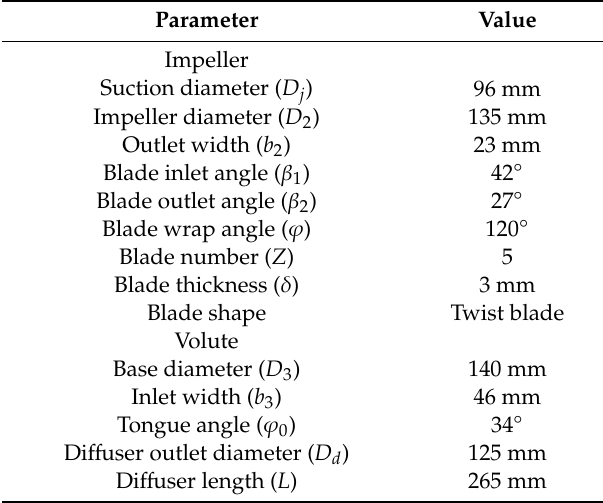
Table 1. Main parameters of centrifugal pump impeller.